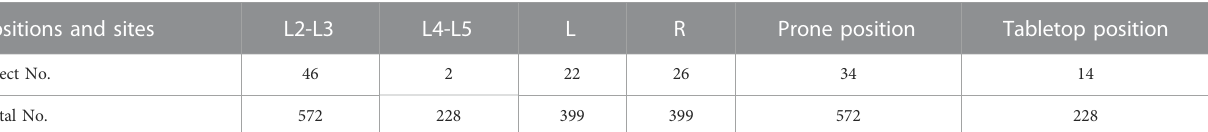
TABLE 8 The number of features at different positions and sites of the optimal feature set. Positions and sites L2-L3 L4-L5 L R Prone position Tabletop position Select No. 46 2 22 Total No. 572